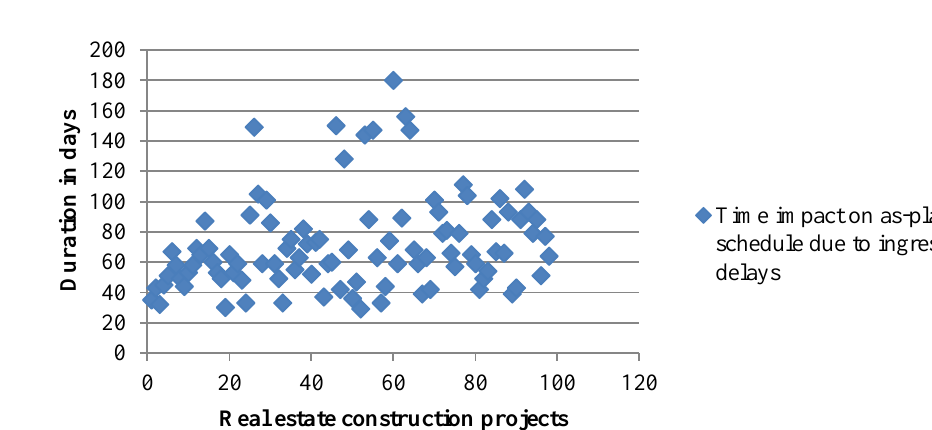
Fig. 2. Time impact study [figure made by authors].